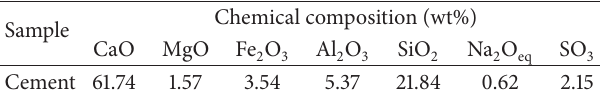
Table 2: Chemical composition of cement.